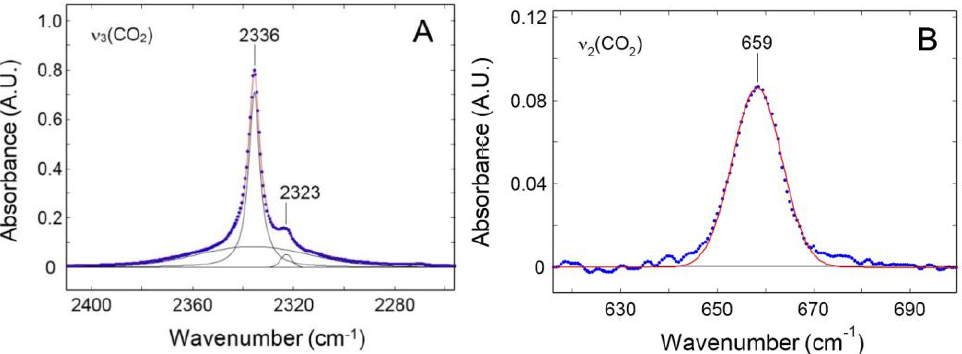
Figure 5. Band shape analysis of the ν 3 ( A ) and ν 2 ( B ) modes of CO 2 sorbed in PPO. The spectrum, obtained by Difference Spectroscopy, refers to the test performed at 201.6 Torr. Blue dots: experimental data. Red line: simulated profile. Black lines: resolved components. The ν 3 profile represented in Figure 5A displayed a secondary maximum at 2323 cm −1 .